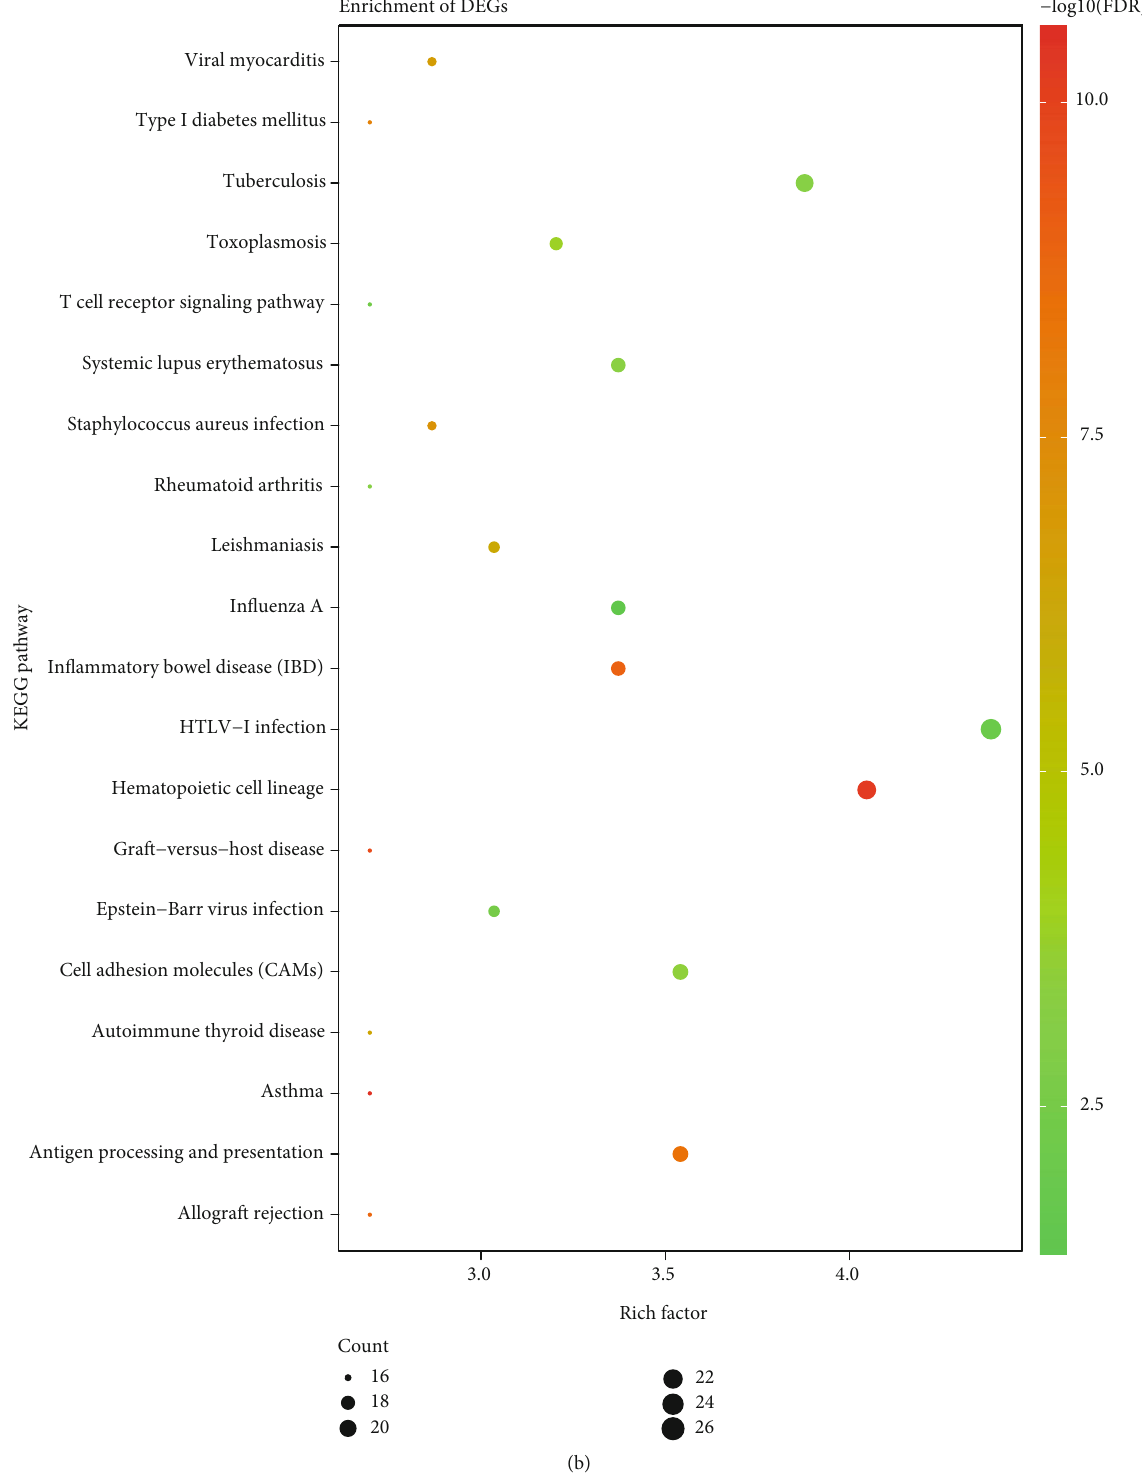
Figure 2: GO and KEGG enrichment analyses of DEGs. (a) Shows the results of biological process terms enriched by GO analysis. (b) Shows the enriched pathway by KEGG analysis. The colored dots represent the FDR for that term, with red representing greater signi fi cance. The size of the dots represents the number of involved genes. The rich factor represents the proportion of enriched genes for each